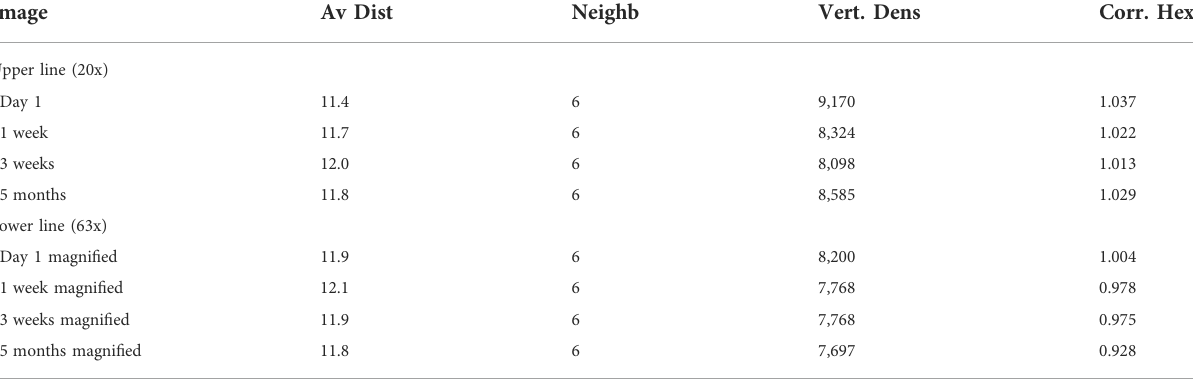
TABLE1ImageanalysiswasperformedonthepicturesinFigure3.Theresultsforeachimagearetheaveragedistancebetweenastervertexes(mean), connected neighbours (median), number of vertexes in 1 mm 2 and correlation to the theoretical hexagon model. Image Av Dist Neighb Vert. Dens Corr.